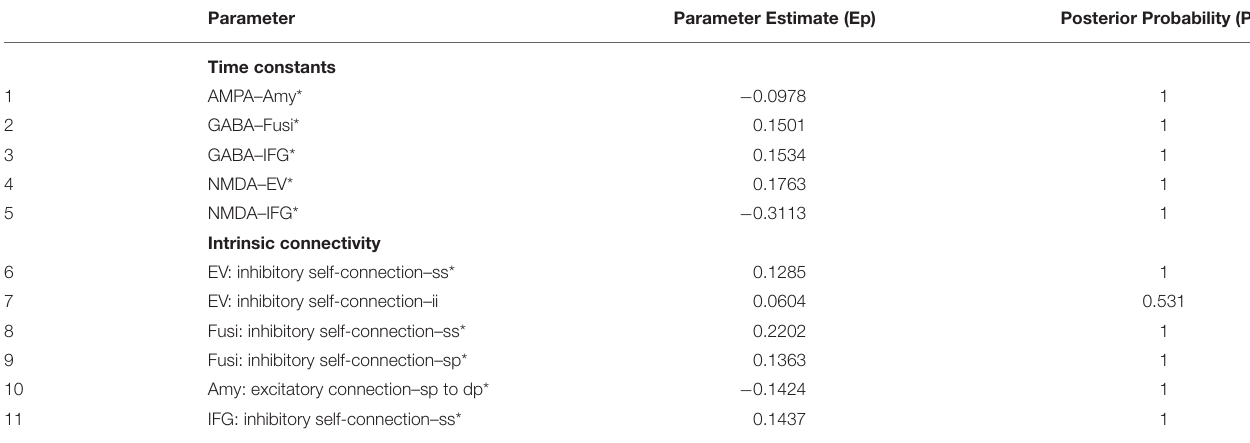
TABLE 1 | Group effects over parameters.